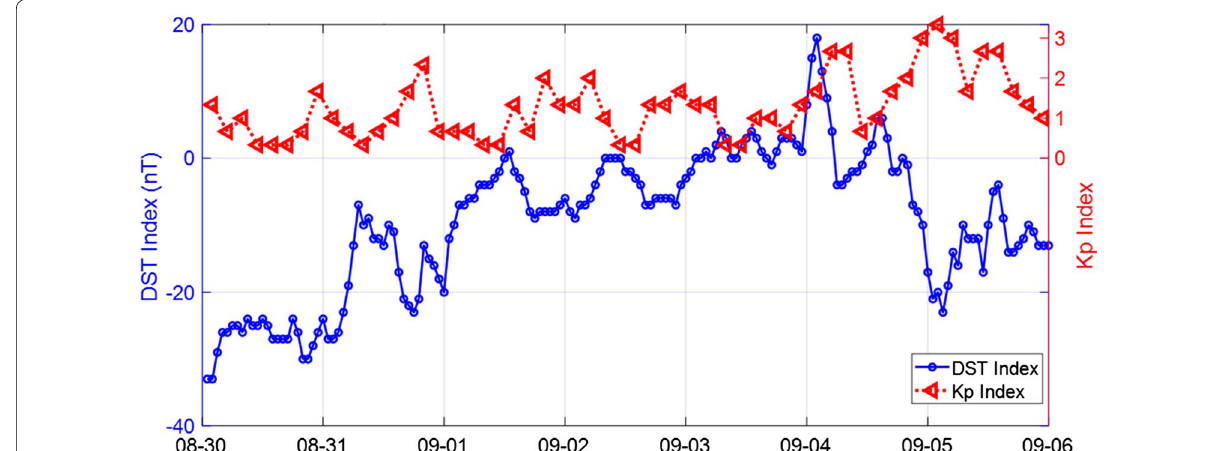
Fig. 20 The Dst index and Kp index from August 30 to September 3, 2018